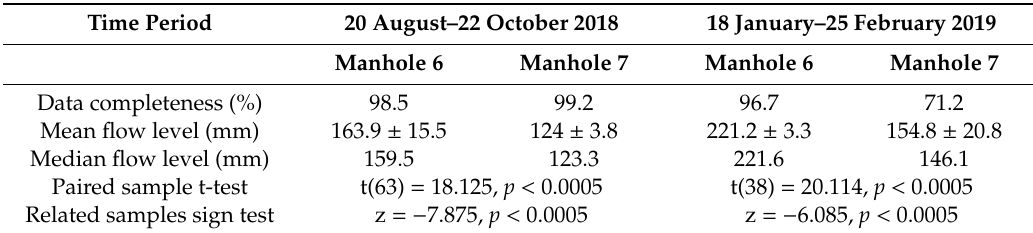
Table 1. Results of the statistical analysis of the di ff erences in flow level (mm) recorded by the ultrasonic sensors upstream (manhole 6) and downstream (manhole 7) of the SuDS tree